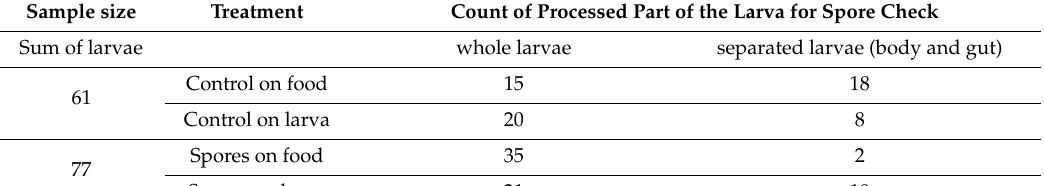
Figure A2. Male head capsule width and fresh body weight (pharate dataset), N = 363. Table A1. Overview for processed larvae and pharates during sampling.